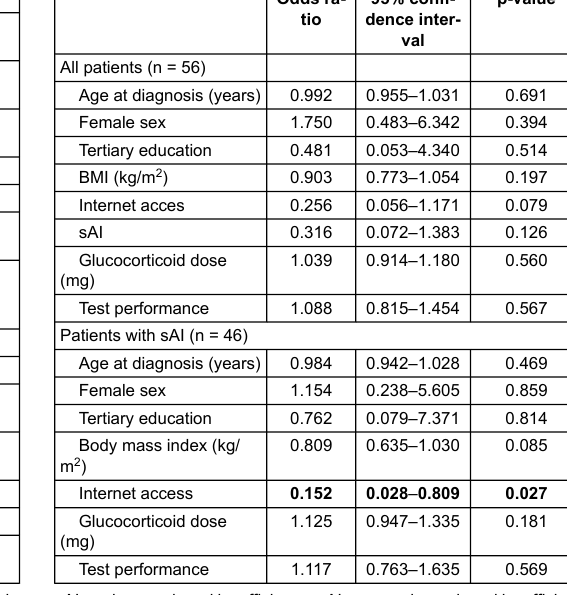
Table 5: Risk factors for adrenal crisis in all patients with adrenal in- sufficiency and in a subgroup of those with secondary adrenal insuffi- ciency (binary logistic